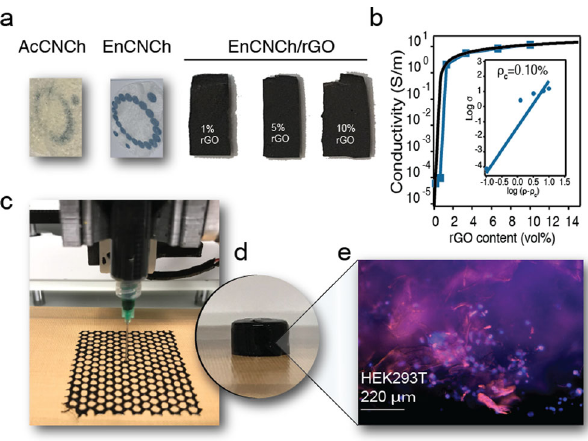
Fig. 6 EnCNCh/rGO fi lms fabrication. a Detail of CNCh fi lms from left to right: AcCNCh fi lm, EnCNCh fi lm (obtained with LFACA-LPMO), EnCNCh fi lm 1%wt rGO, 5%wt rGO and 10 wt rGO. EnCNCh is transparent and had good integrity unlike AcCNCh that was very weak and not as translucent. b Conductivity of EnCNCh for different reduced graphene contents: 0.3, 1, 2, 5, 10 and 15 wt% rGO (blue squares and blue line to guide the eye) and fi tting (black line). Calculations were made with volumetric % of reduced